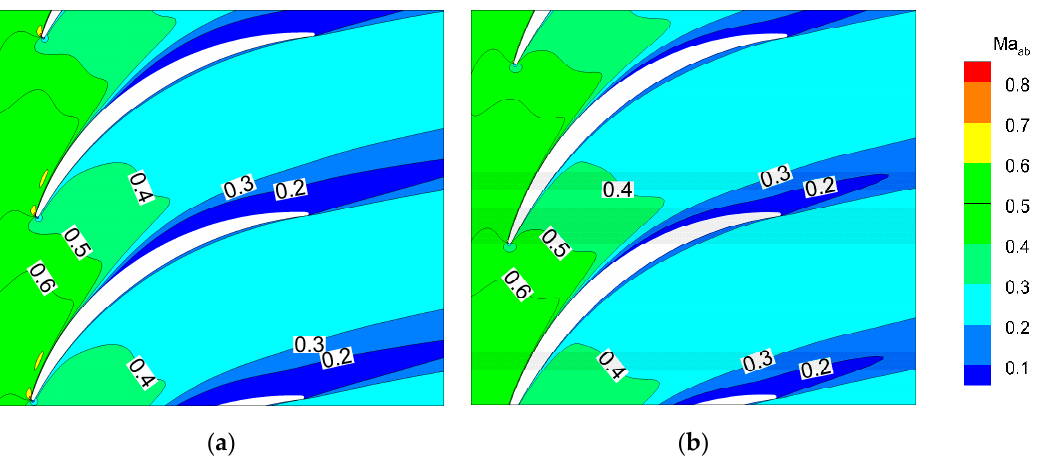
Figure 19. Absolute Mach number in 95% of the span height of the second-stage stator for original and optimized compressor. ( a ) Absolute Mach number for original compressor; ( b ) absolute Mach number for optimized compressor.